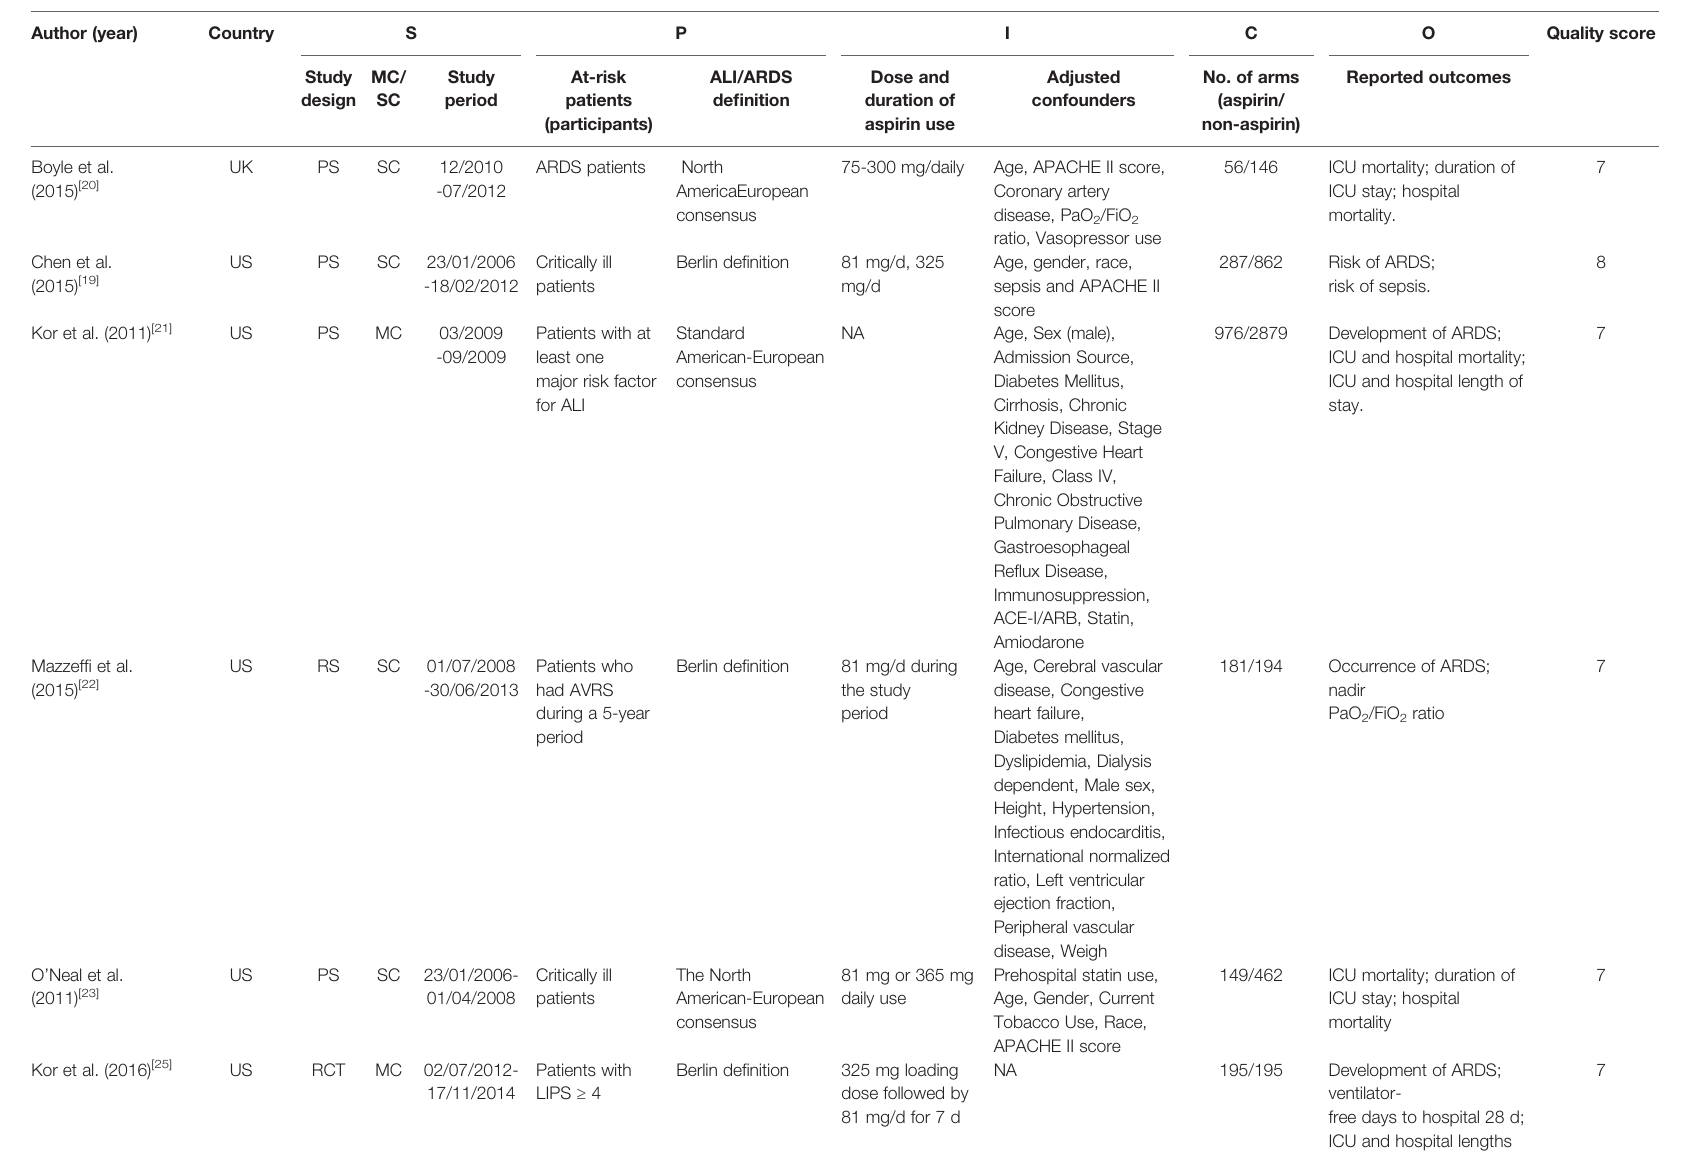
TABLE 1 | Characteristics of the included